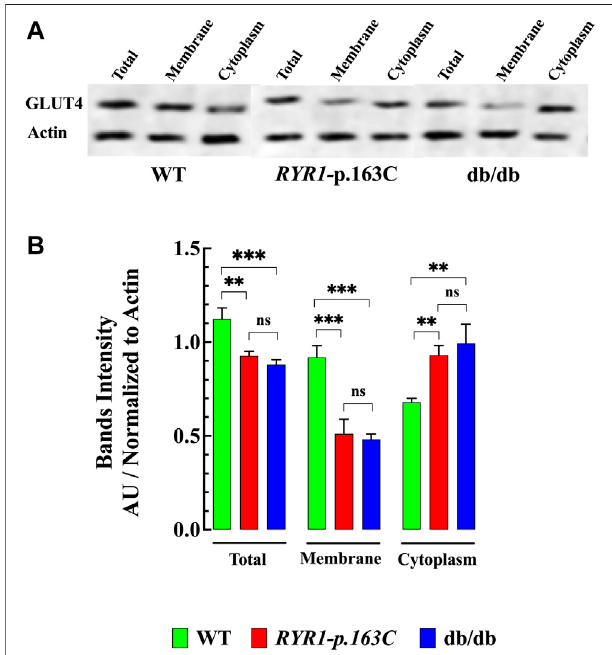
FIGURE 7 | Expression and subcellular distribution of GLUT4 in skeletal muscle. The total expression of GLUT4 was signi fi cantly lower in RYR1 - pR163C and db/db gastrocnemius muscle compared to age-matched WT muscle. Furthermore, the GLUT4 subcellular membrane fraction was signi fi cantly reduced in RYR1 -pR163C and db/db muscles compared to WT; in contrast, the cytoplasmic fraction of GLUT4 was higher in RYR1 -pR163C and db/db muscles than in WT. (A) Representative immunoblots collected from WT, RyR1 -p.R163C, and the db/db muscle homogenates. (B) Densitometric quanti fi cation of the global and subcellular distribution of GLUT4 in WT, RYR1 -pR163C, and db/db muscle. Values are expressed as mean ±S.D. Experiments were carried out in n mice = 3 per genotype, n WB = 5. Statistical analysis was performed as described above. ns = non signi fi cative, ** = p < 0.01, *** = p <